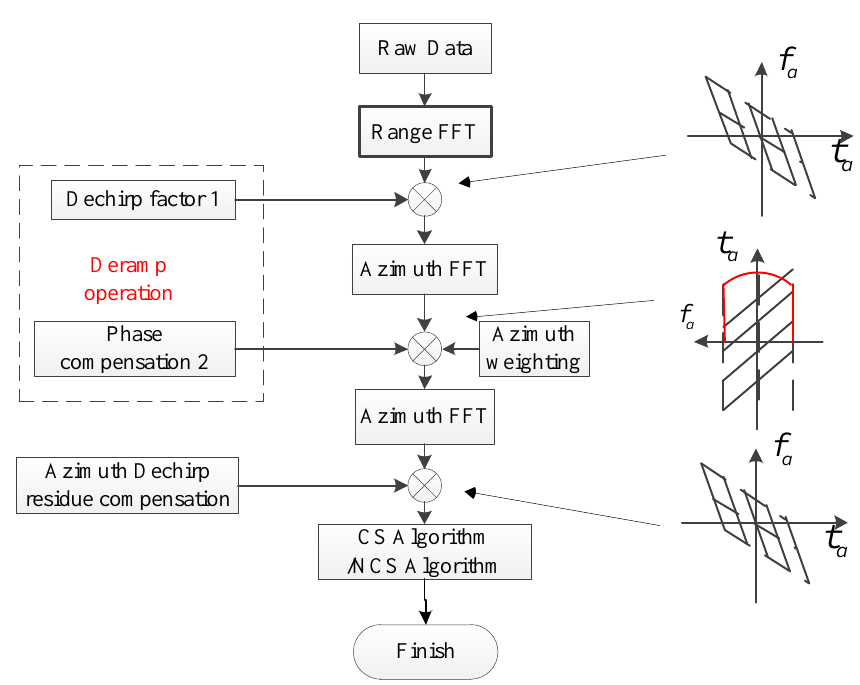
Figure 5. In the procedure of the algorithm of sliding-spotlight SAR imaging, the weighting method is carried out in the range frequency domain. The red line shows the window in the weighting method. The right three pictures shows the time frequency relationship in the processing steps.